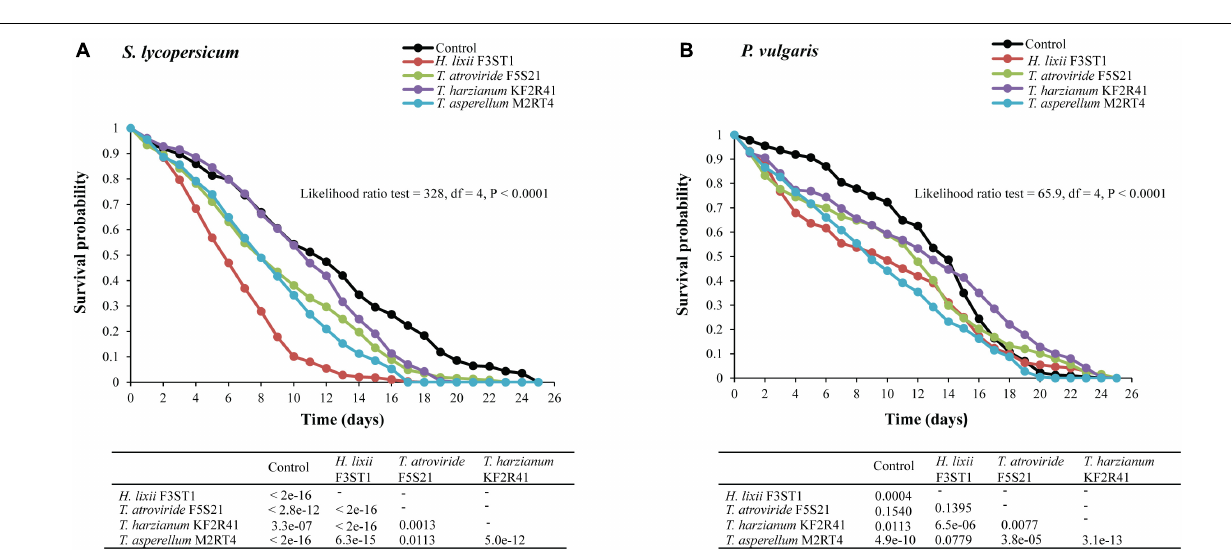
and 38.13% with 8 (7–9) days for T. atroviride F5S21, and